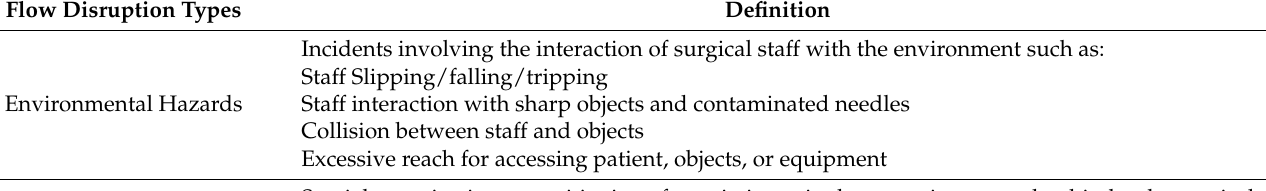
Table 1. Definitions of different types of flow disruptions